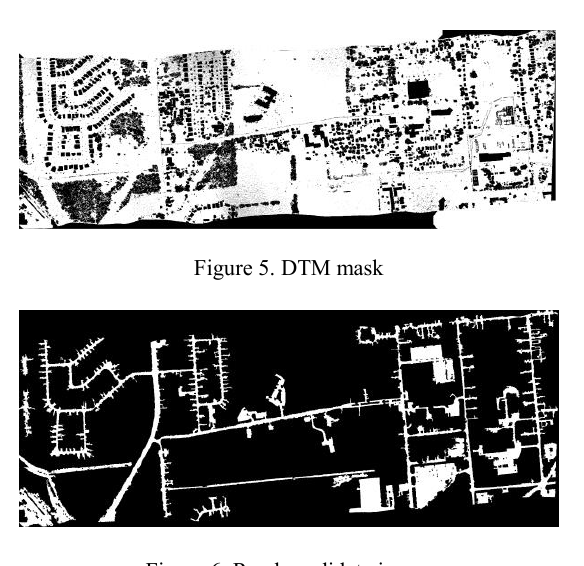
Figure 6. Road candidate image